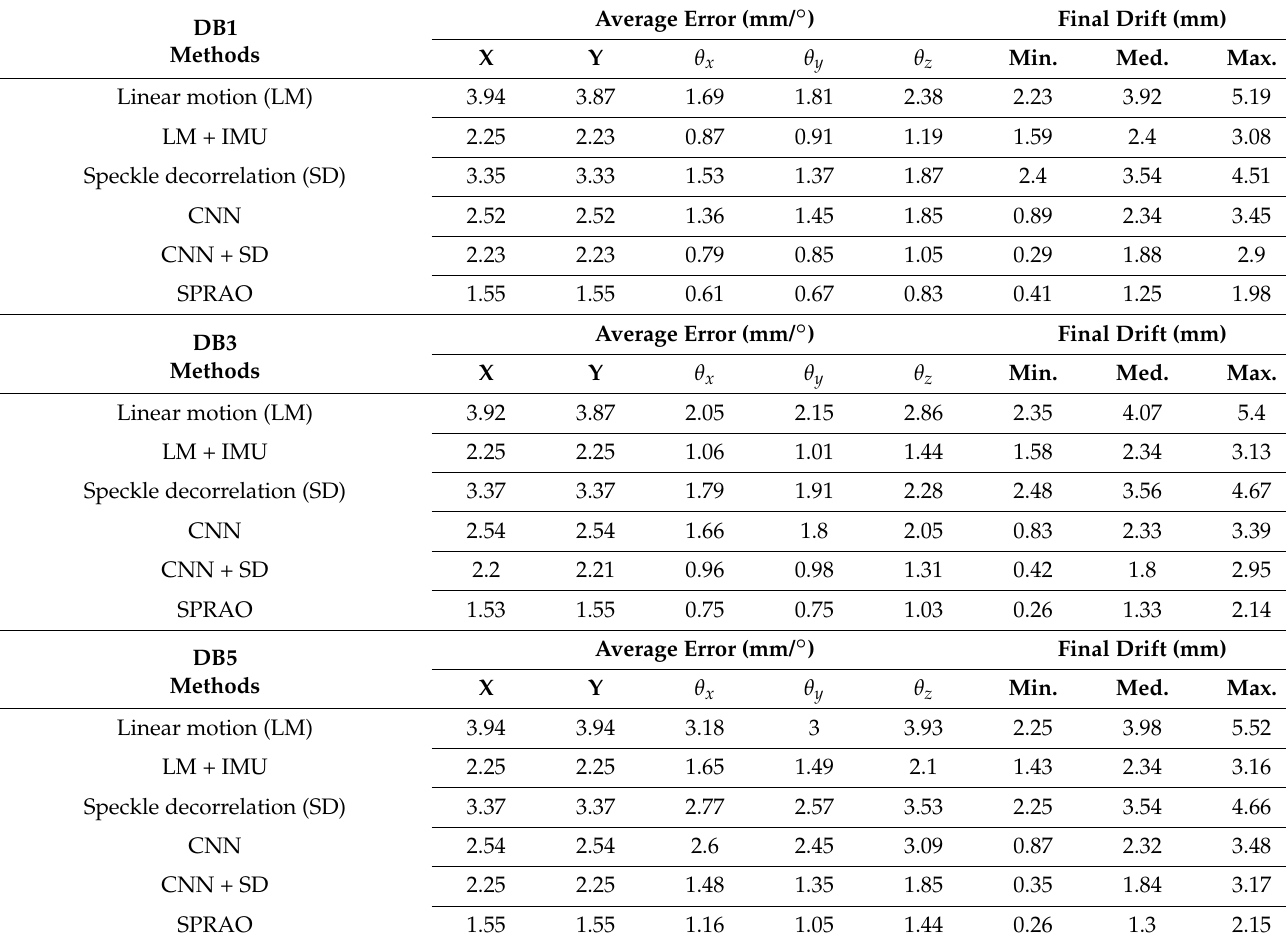
Table 3. Comparison of average error and final drift of different